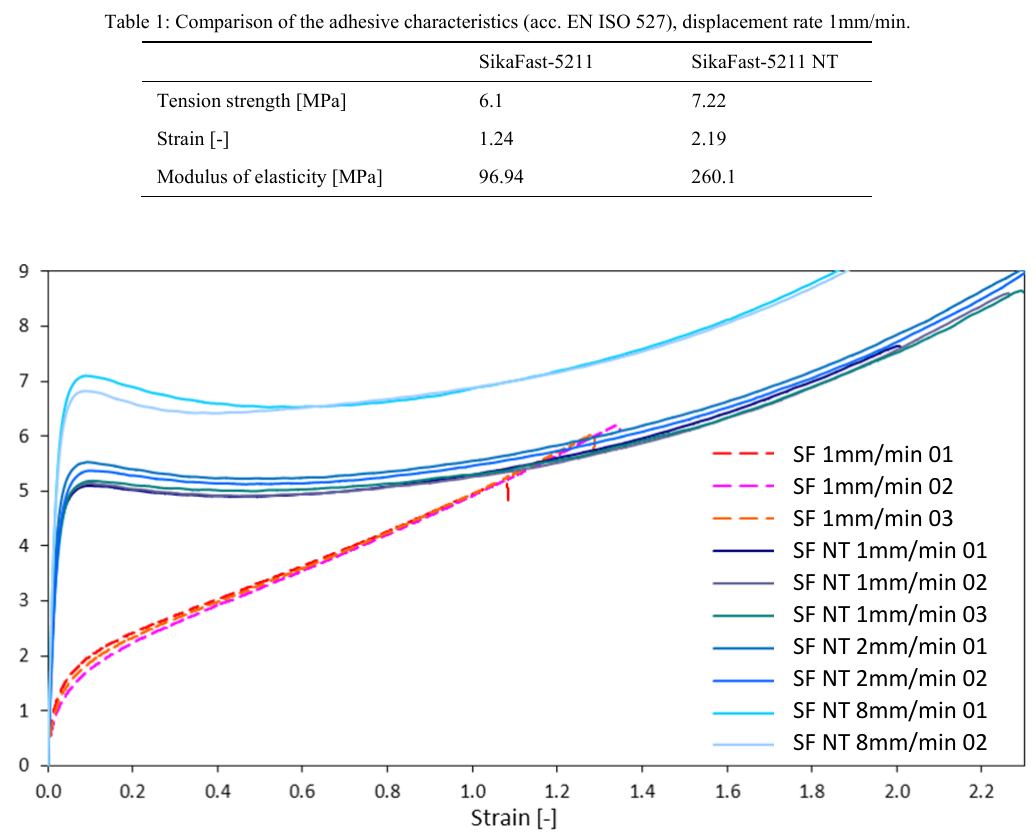
Fig. 2 Stress-strain relationship for both